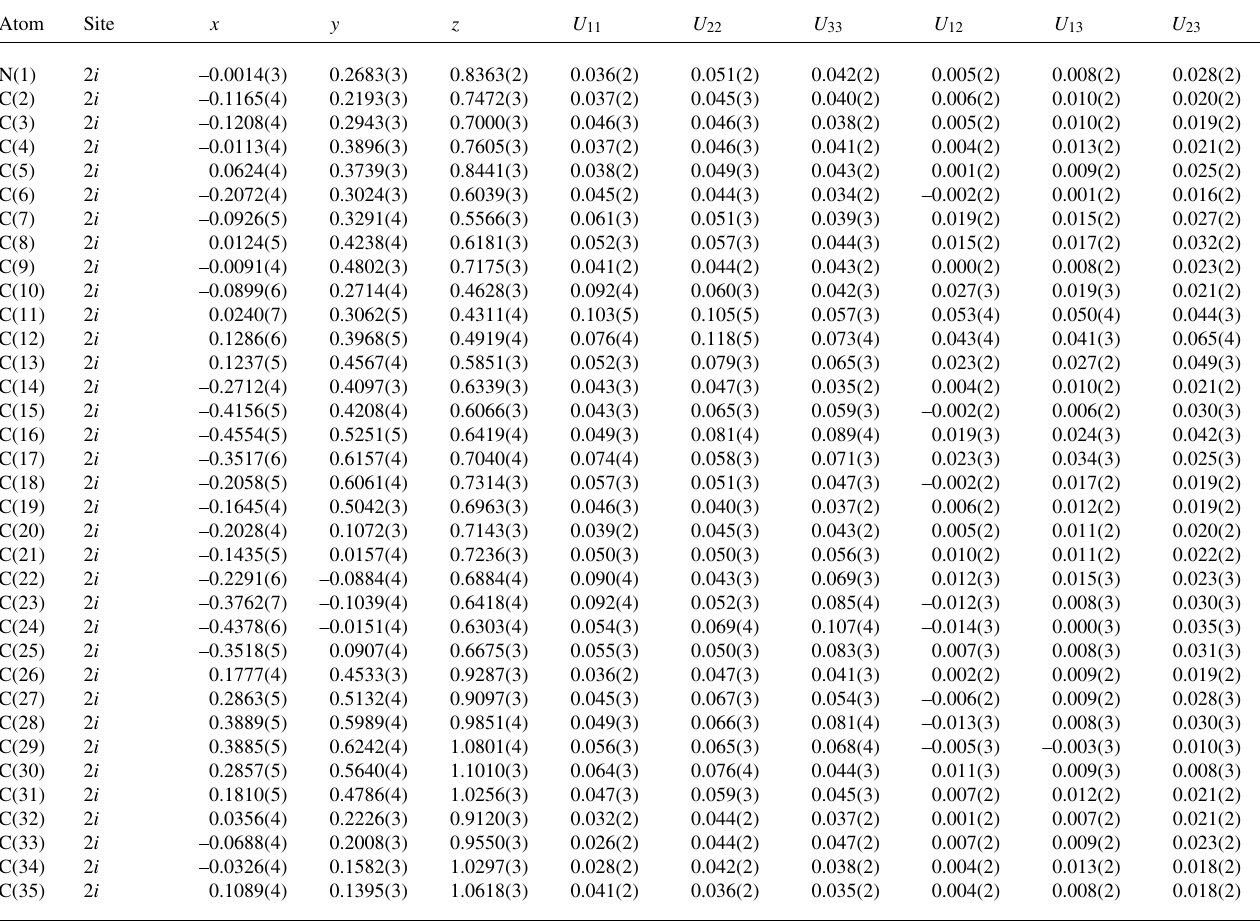
Table 3. Atomic coordinates and displacement parameters (in Å 2 ) .